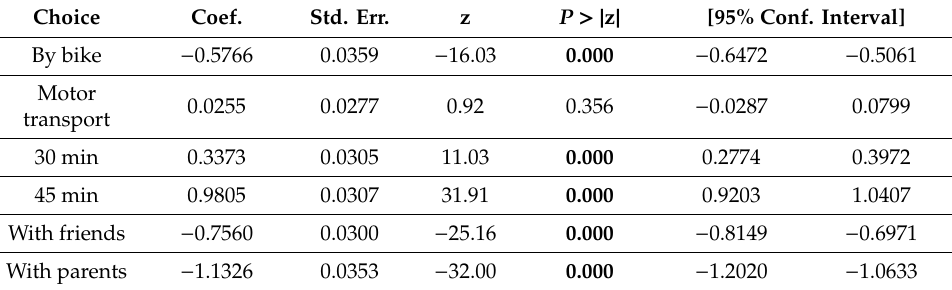
Table A4. Analysis of main e ff ects driving adolescents’